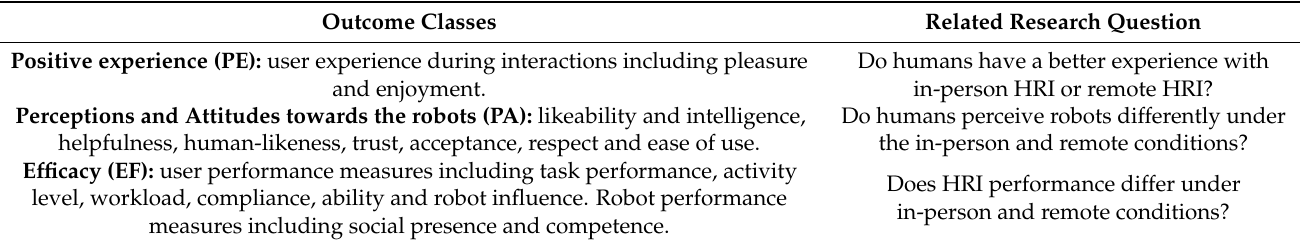
Table 2. Summary of the Remote and In-person HRI